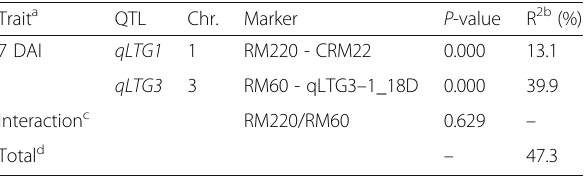
Table 1 QTL analysis for low-temperature germinability in the